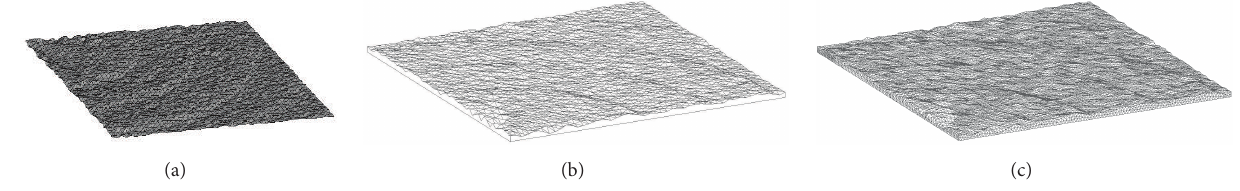
Figure 10: Example of a generated fractal surface (a); solid geometry (b); mesh of the numerical model